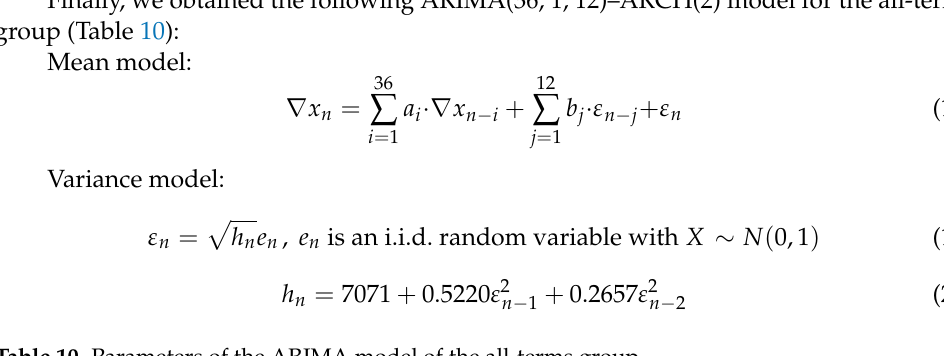
Table 10. Parameters of the ARIMA model of the all-terms